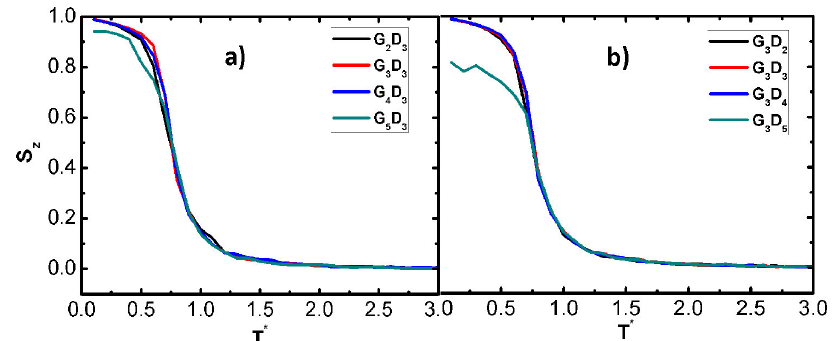
Figure 5. Average orientational order parameter as a function of temperature, T ∗ for LCDrs = 3 and G = 2 – 5 and ( b ) fixed G = 3 and f with ( a ) fixed f c